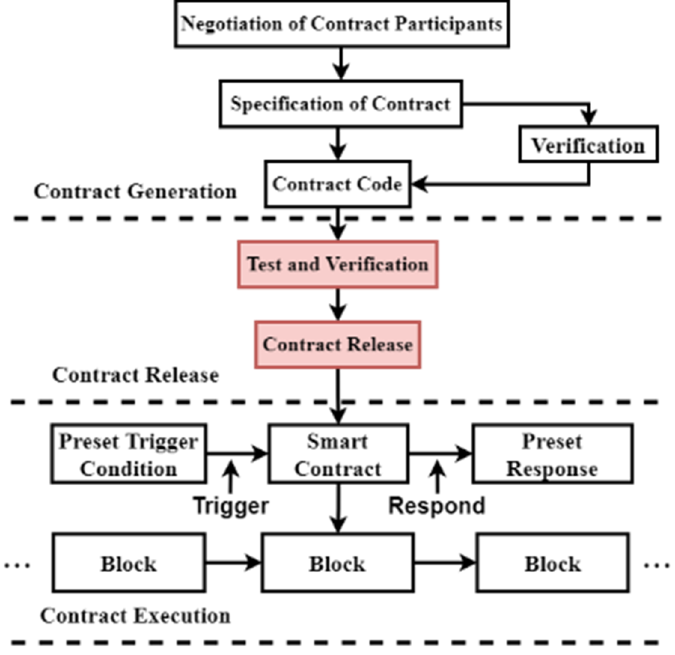
Figure 1. The life cycle of a smart contract.